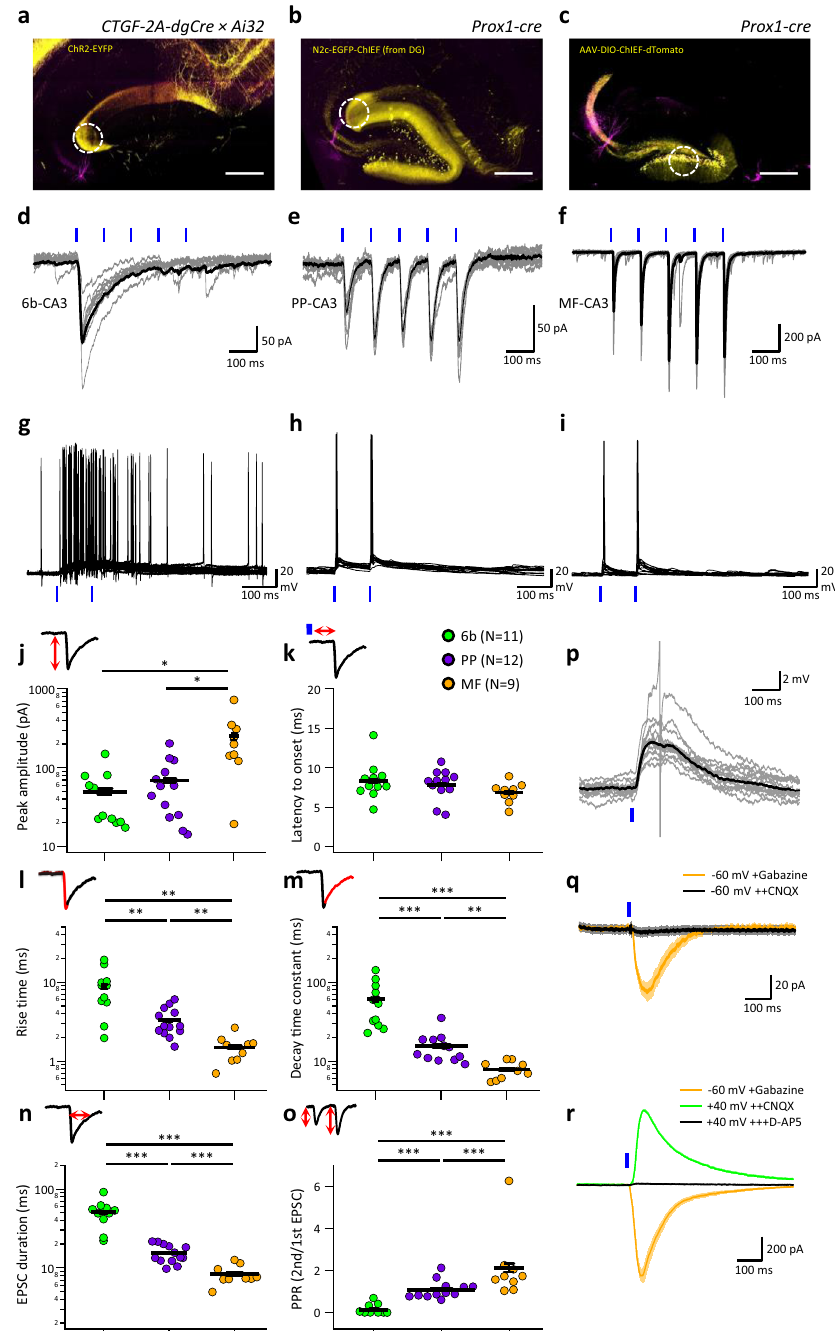
Fig. 4 | Synaptic physiology of the EC-6b to CA3 projection. a – c Representative images of acute hippocampal slices following speci fi c expression of optogenetic actuators (yellow) speci fi cally in EC-6b ( a ), EC-2 ( b ), or the DG ( c ) while recording post-synaptic responses from neurons in CA3b (magenta). White dashed circle indicates region targeted for photostimulation, and scale bars represent 200 µ m.